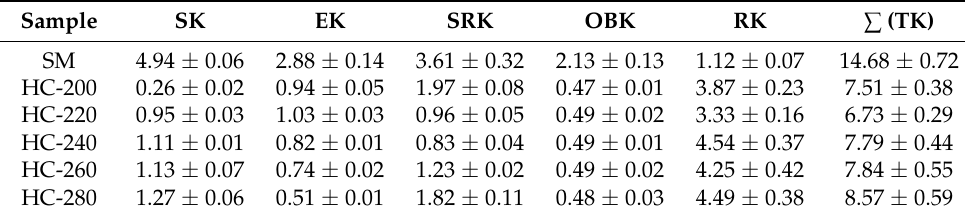
Figure 5. Changes in the forms of K between raw SM and hydrochars obtained at different reaction temperatures. Table 4. Different forms of potassium in raw SM and hydrochars obtained at different reaction temperatures (mg/g, dry basis).